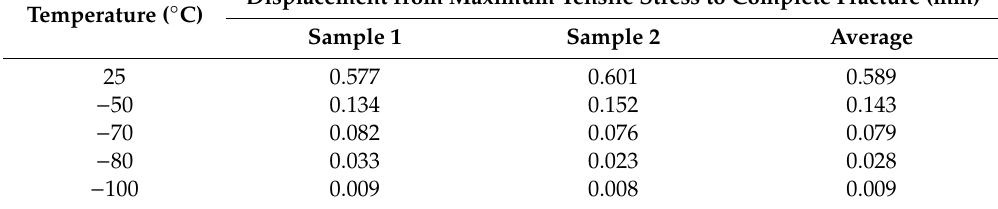
Table 2. Displacement from maximum tensile stress to complete fracture of Sn3.0Ag0.5Cu solder joint at di ff erent